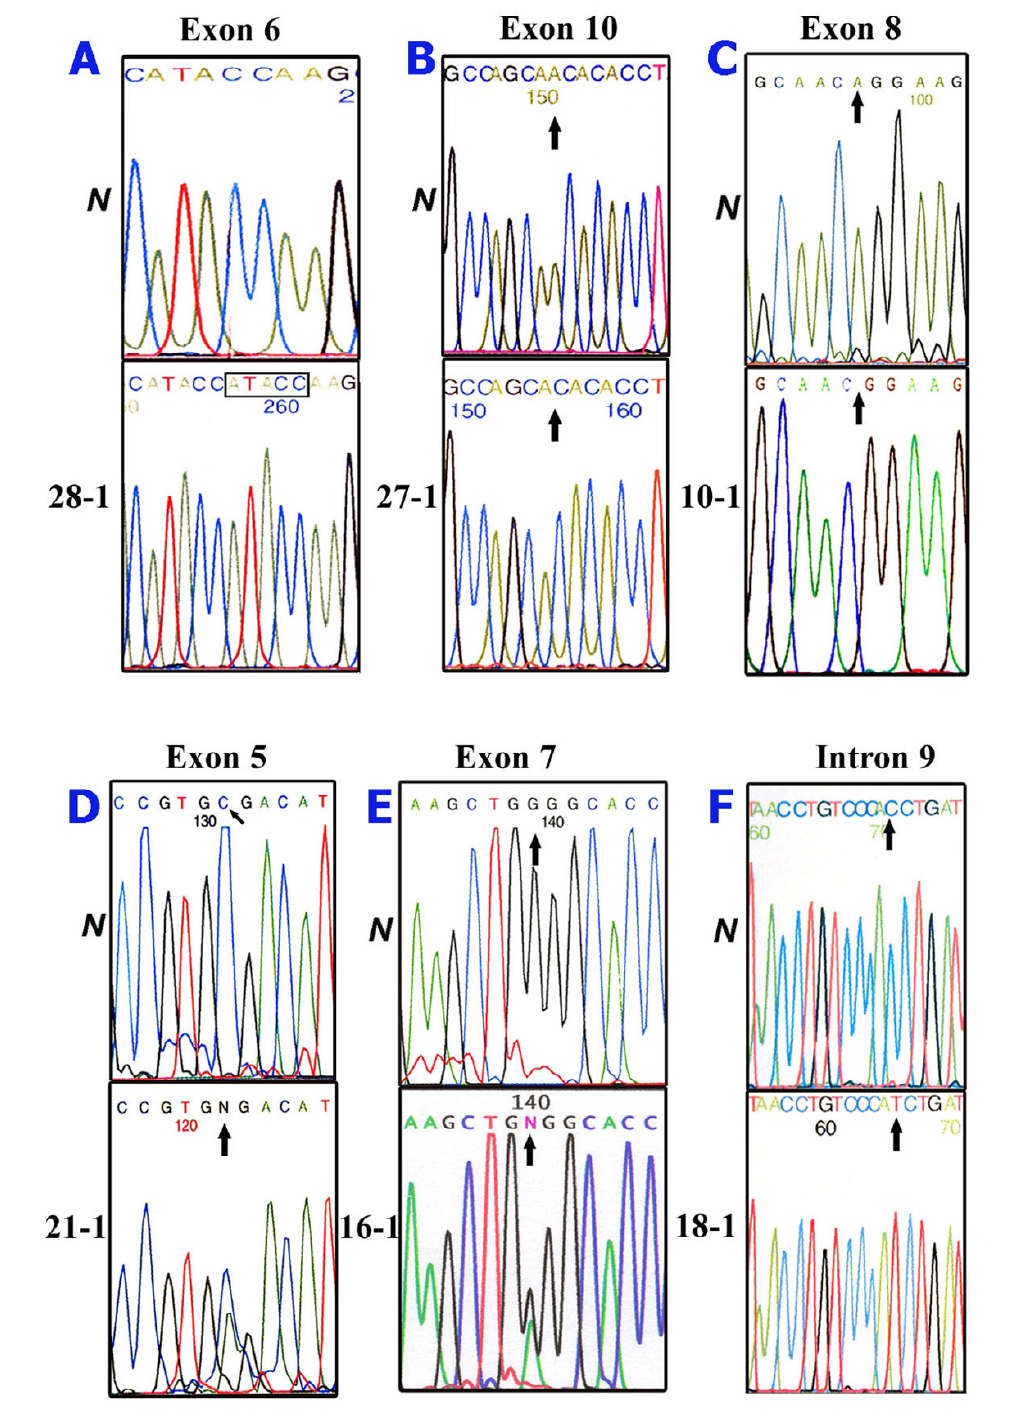
Figure 3 Electropherogram showing the mutant and normal controls of PAX6 gene. Chromatogram showing the sequence variations in PAX6 gene is indicated by arrow. Plasmid based sequencing revealed c.715ins5 in 28–1 (A), c.1201delA in 27–1 (B), c.901delA in 10–1 (C) and IVS9-12C>T in 18–1 (F). Direct sequencing revealed c.482C>A in 21–1 (D), and c.830G>A in 16–1 (E), N- Normal control, Box- duplication of